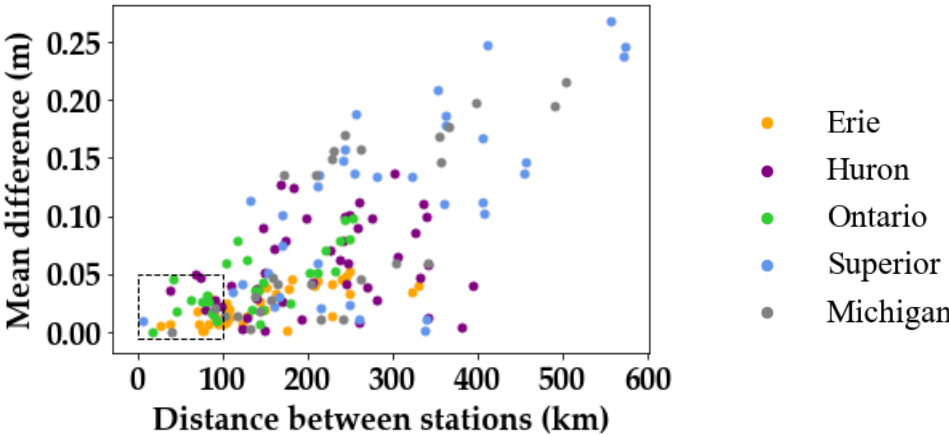
Figure 3. Mean absolute differences of the in situ water level measurements as a function of the distance of the gauge stations (by pairs).